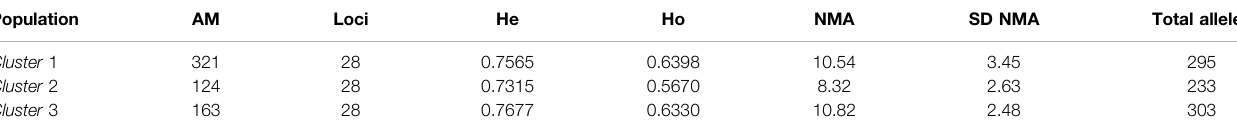
TABLE 4 | Indices of genetic diversity among clusters of breed characterization of Curraleiro Pé-Duro cattle. Population AM